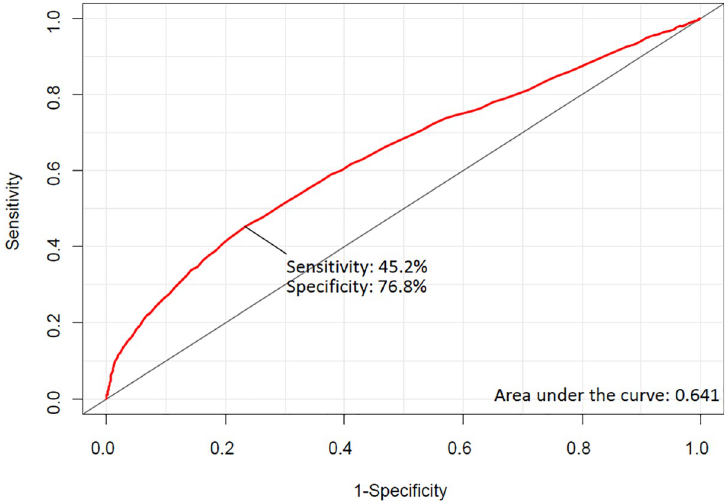
Fig 3. Receiver-operating characteristic curves for intraoperative hemoglobin level associated with myocardial injury after non-cardiac surgery.